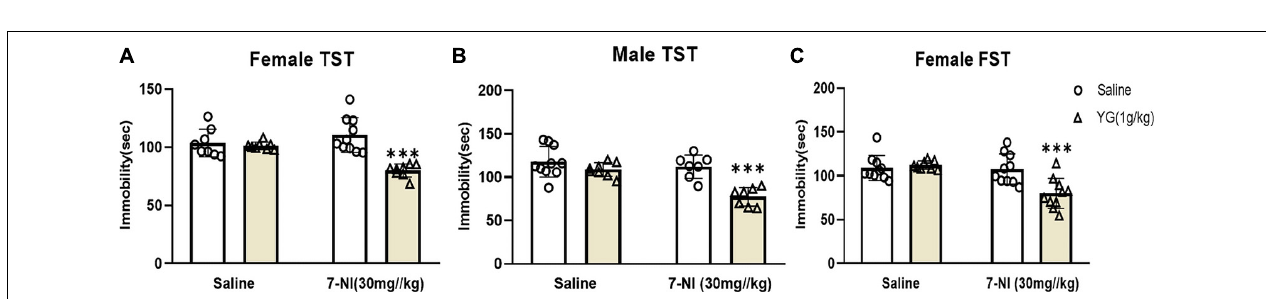
FIGURE 4 | Antidepressant-like effects of YG following nNOS intervention. The effect of 7-NI (30 mg/kg, i.p.) pretreatment on the antidepressant response of YG (1 g/kg, i.g.) in the TST of (A) female and (B) male mice. Meanwhile, (C) FST was also used to evaluate the interaction between YG and 7-NI. ∗∗∗ p < 0.001, compared with Control + Saline. Two-way ANOVA, n =